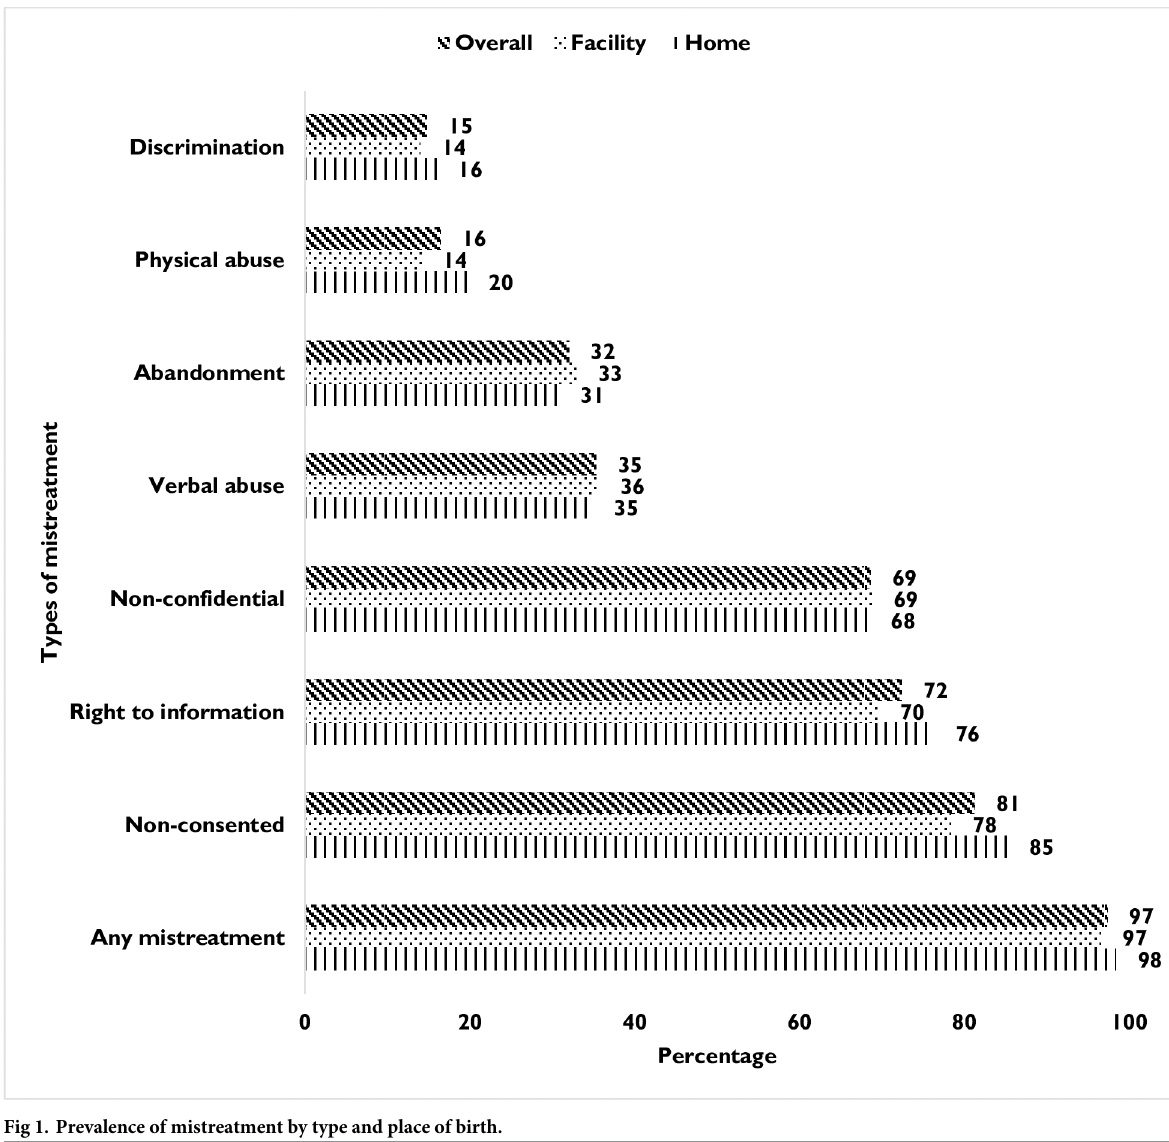
Fig 1. Prevalence of mistreatment by type and place of birth.